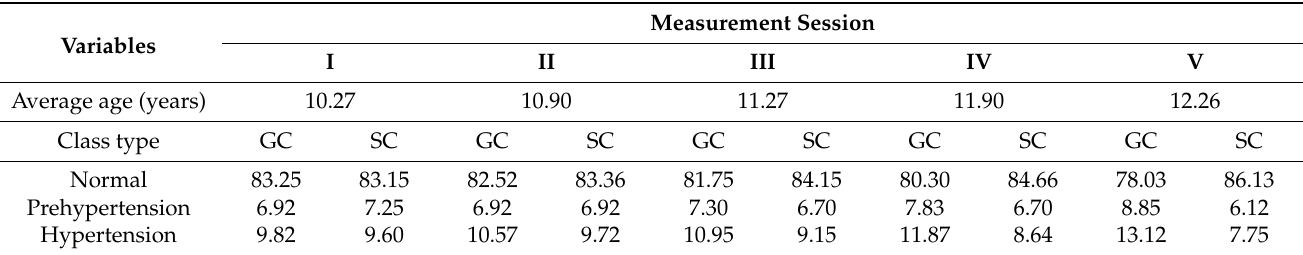
Table 2. The changes in the percentage of children in particular systolic blood pressure categories from the initial to the final measurement sessions